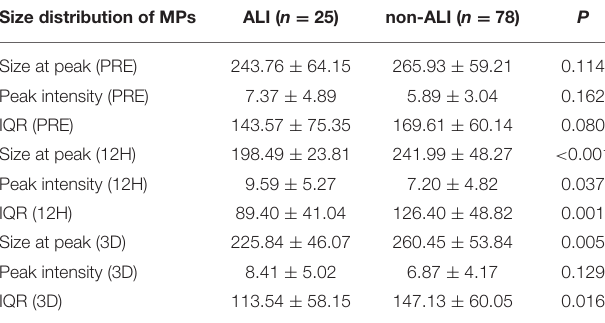
TABLE 4 | Size distribution of MPs between the ALI and non-ALI